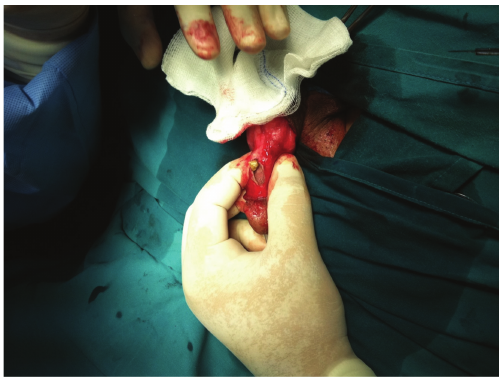
Figure 1: Retrieval of the stones from inside the cyst.